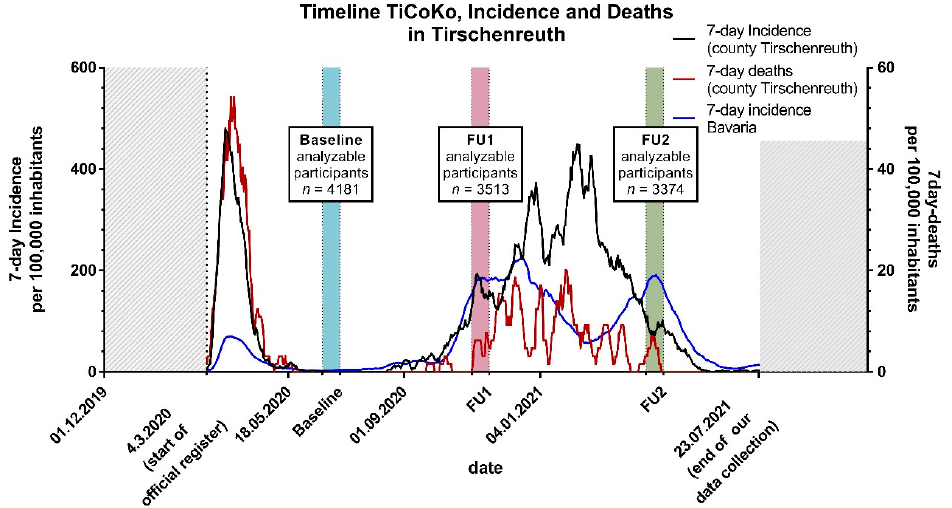
Figure 2. Overview of the time of assessments in the context of Tirschenreuth county SARS-CoV-2 infection waves. Shown are, over time, the 7 day registered infection incidence, the 7-day registered COVID-19 related death incidence per 100,000 of Tirschenreuth county inhabitants and the time of study assessments. Also shown are the numbers of enrolled participants and the number of analyz- able participants, i.e., with successful N test measurements at BL, at FU1 and BL, and at FU2 and BL, respectively. N-test measurements for all three time point were available for n = 3177. When comparing the characteristics of FU1 and FU2 participants with respective dropouts, we found significant difference regarding age and sex, but not with regard to reported comorbidity or education ( p < 0.05) (Table 1 and Supplementary Table S1). A significant difference was also found with regard to seropositivity at BL, which was con- sistently higher in those returning at FU1 and FU2 (Table 1 and Supplementary Table S1), reasoning individuals seropositive at BL were more interested in the follow-up than indi- viduals seronegative at BL. Total N-seropositivity at FU1 or FU2 can thus be biased by the confounding effect of differential response with regard to seropositivity at BL. Estimation of new seropositivity at FU1 among those seronegative at BL and at FU2 among those seronegative at FU1 is not biased by this differential response. This further supported our approach to derive total % of ever seropositives and the % seropositives at FU1 or FU2 in a step-wise approach (see Section 2.2). Table 1. Participant characteristics. Shown are, as indicated, median and IQR or percentage and number of individuals for the given characteristic for analyzable participants at BL, FU1, and FU2.